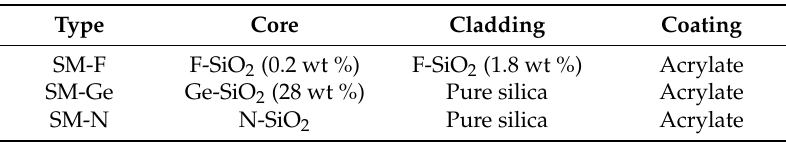
Table 1. Characteristics of tested fibers and tested